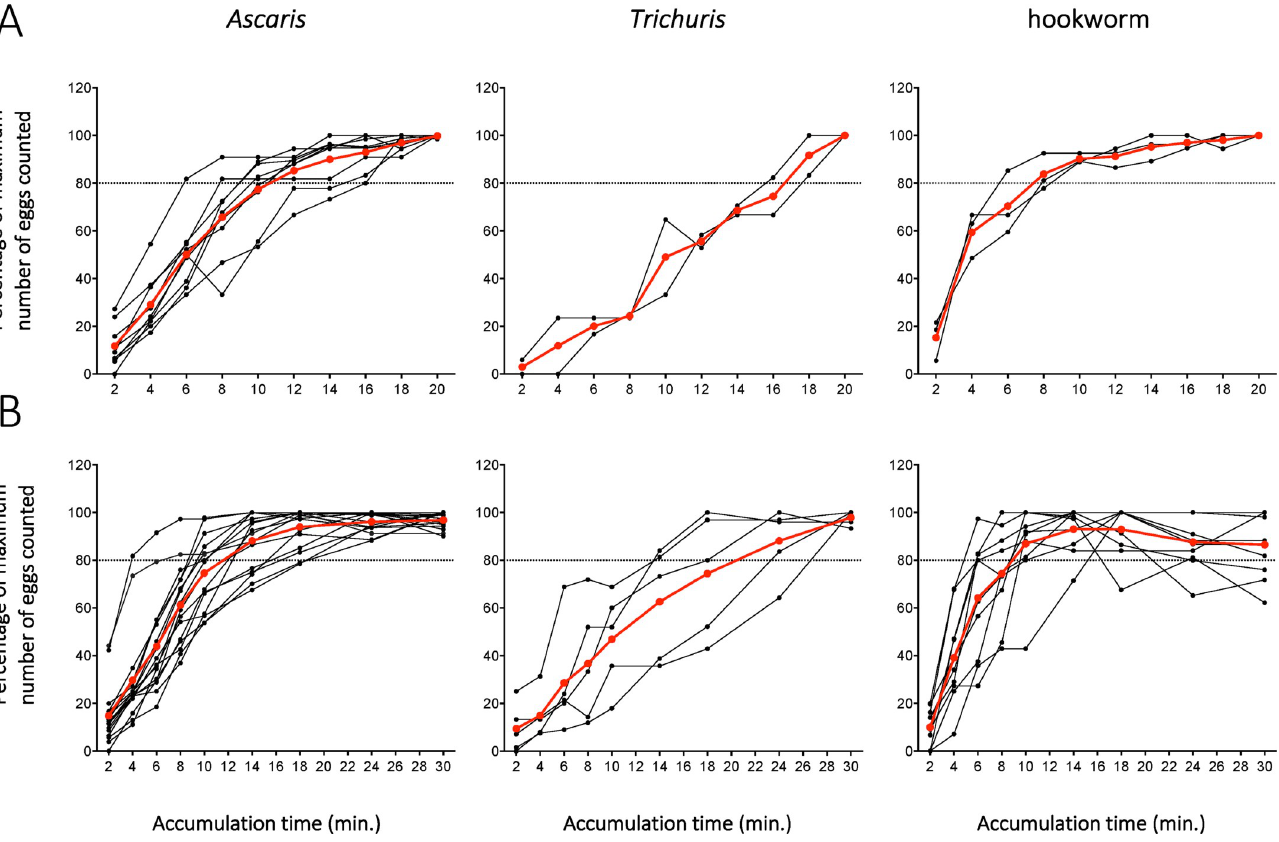
Fig 6. Line plots showing the average relative amount of STH eggs counted in FECPAK G2 cassettes over increasing accumulation times. The average relative percentage of visible eggs in the different samples over the different time points is indicated in red. Panel A shows the results obtained from the accumulation experiment performed with 10 samples from Ethiopia where samples were imaged for 20 minutes. Panel B shows the combined results obtained from the accumulation experiment performed with 30 additional samples (10 from Brazil, 10 from Laos and 10 from Tanzania). These samples were imaged for a total of 30 minutes. A grey horizontal dotted line is drawn at the height of 80% of maximum number eggs counted in the cassette